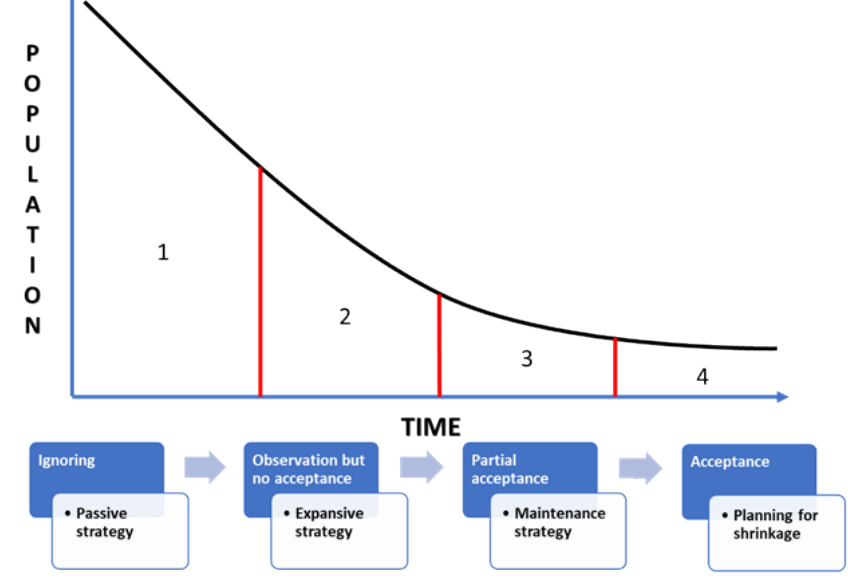
Fig. 1. The phases of accepting shrinkage and strategies to cope with it (adapted from Pallagst et al. 2017; Hartt